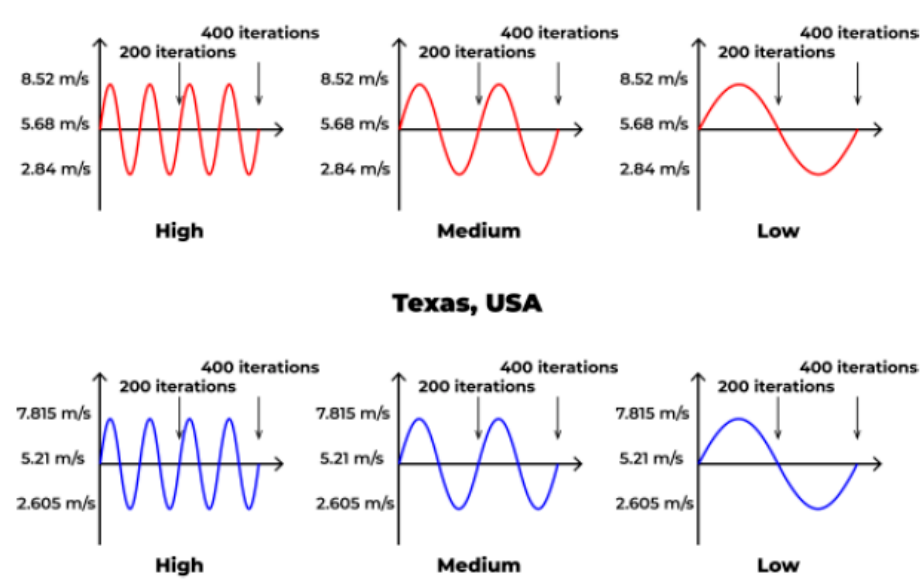
Figure 2. Wind speed graphs of three di ff erent frequencies for Inner Mongolia, China ( top ) and Texas, USA ( bottom ).